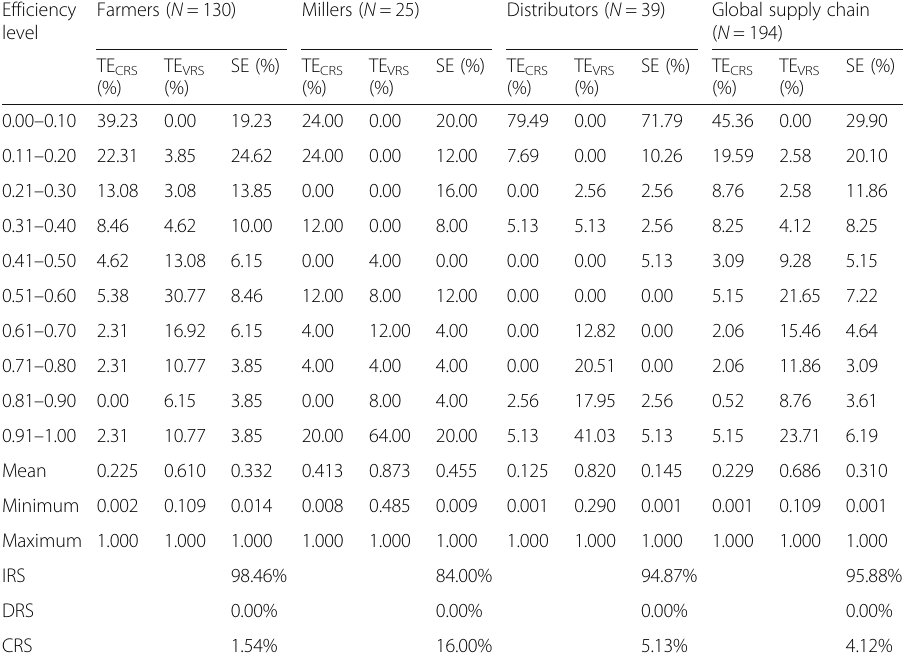
Table 9 Percentage distribution of the technical and scale efficiency index for the actors and the global rice supply chain Efficiency Farmers ( N = level